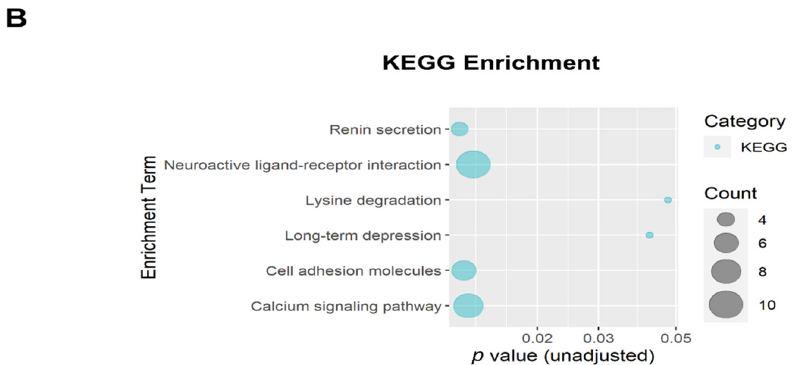
Figure 6. Bubble plots of gene enrichment results from the top CpG sites (unadjusted p < 0.005 and | ∆ β | ≥ 0.05; mapped to 258 genes) associated with opioid exposure. ( A ) The top 15 Gene Ontology (GO) enrichment terms. GO terms are color-coded by subcategory (Biological Process vs. Cellular Component). All unadjusted p ≤ 6.4 × 10 − 4 and all adjusted p ≤ 0.054. Ten GO enrichment terms met the adjusted threshold for significance ( p < 0.05). ( B ) The top 6 Kyoto Encyclopedia of Genes and Genomes (KEGG) enrichment terms. The size of the bubble for each enrichment term corresponds to the number of enriched genes within that pathway. None of the KEGG enrichment terms reached the adjusted significance threshold.